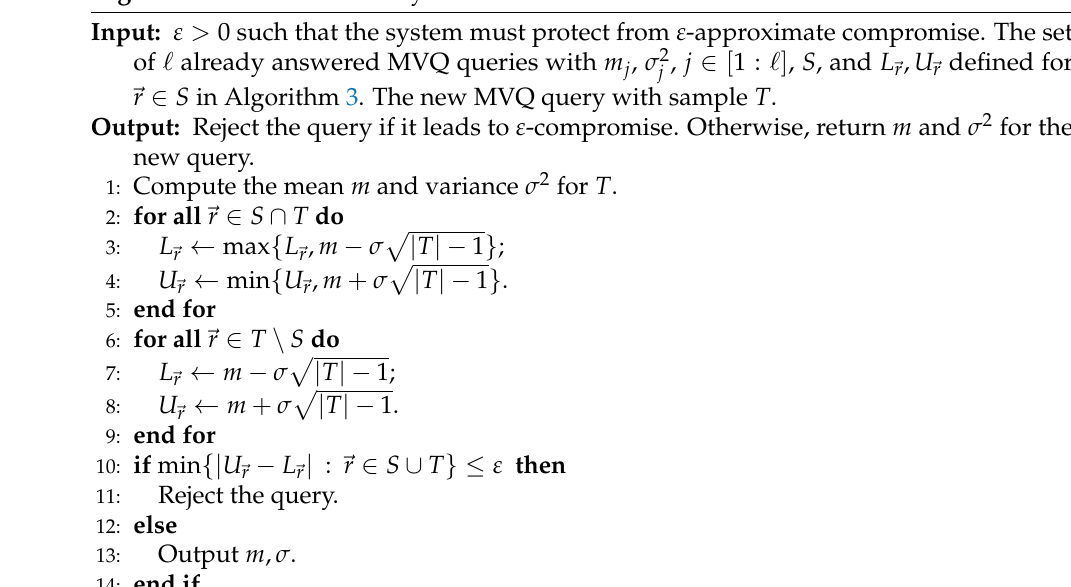
Algorithm 4 Interval Audit